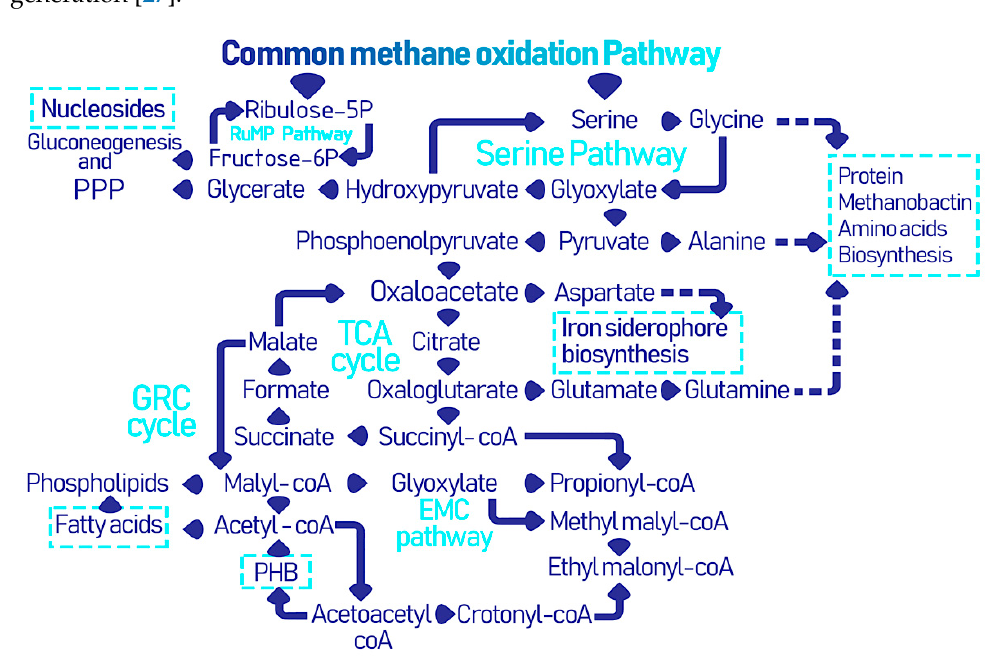
Figure 2. The collective metabolic pathways within methanotrophs leading to the formation of in- dustrially and biomedically valuable biomolecules and biopolymers [25]. industrially and biomedically valuable biomolecules and biopolymers